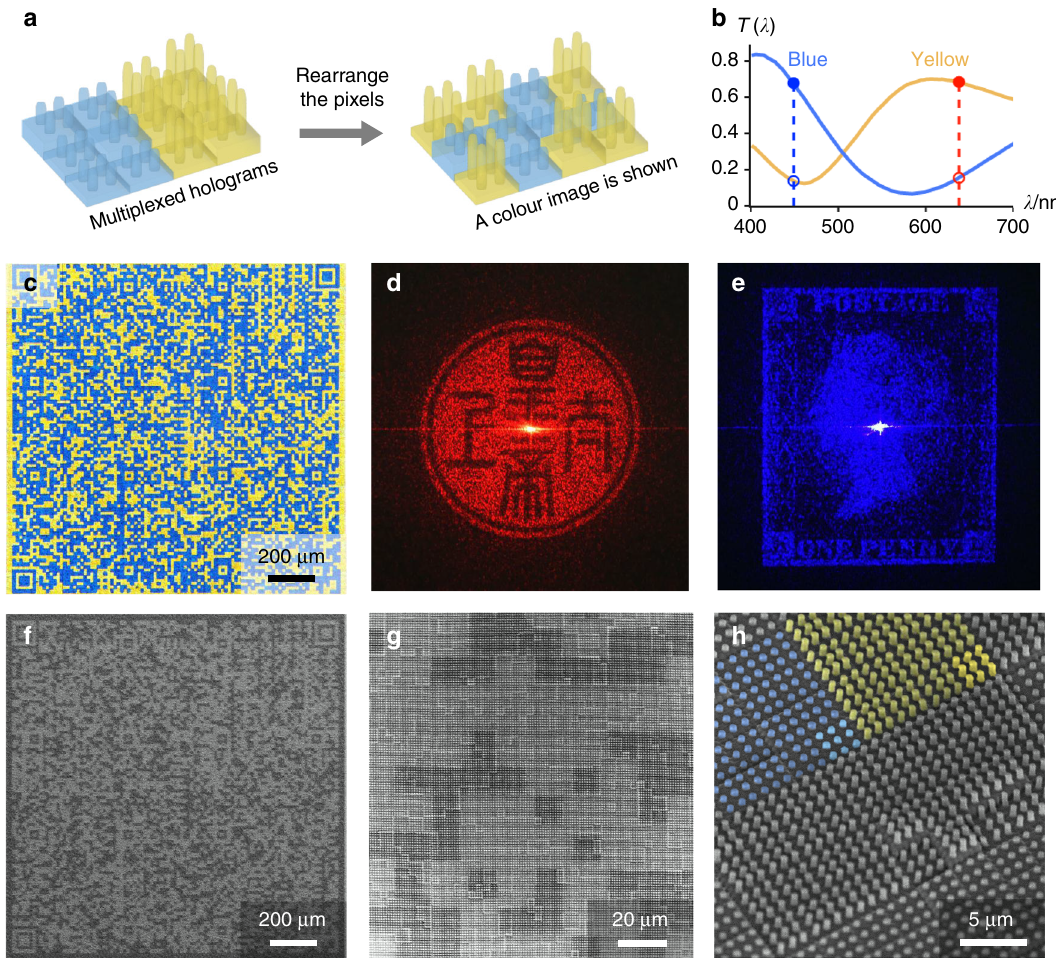
Fig. 3 Proof-of-principle of a two-tone holographic colour print. a Design principle of the holographic colour print: The ability to choose the amplitudes of the pixels independent of their phase makes it possible to rearrange the pixels in a multiplexed hologram (spatial freedom) so that the pixel arrangement contains meaningful information as well, allowing a colour image to be shown on top of the holograms. As long as the pixel arrangement is taken into account when calculating the phase, the individual holographic projections can still be maintained. b Transmission spectra of the yellow and blue colour fi lters used, which have mutually exclusive (orthogonal) transmission at the wavelengths of interest (638 nm red and 449 nm blue). Optical characterisation of the print: c Transmission optical micrograph of a two-tone multiplexed hologram in which the pixels are arranged to form a 480 × 480 pixel colour QR code (1.44 mm square). The blue colour fi lters (blue hologram channel) selectively pass blue light but not red light, whereas the yellow colour fi lters (red hologram channel) selectively pass red light but not blue light. Holographic projections in transmission, photographed on a white wall in a darkened room: d the image of a Chinese seal is shown under 638 nm red laser illumination and e the image of a Penny Black stamp is shown under 449 nm blue laser illumination. The projection size scales with the projection distance, reaching an average size of ~10 cm at a distance of 1 m. f – h Scanning electron micrographs (SEMs) of the print at various scales. Each holographic colour pixel consists of a 3 × 3 pillar array colour fi lter on top of a 3 × 3 μ m 2 phase plate, and each QR code pixel is a super-pixel comprising a 4 × 4 block of holographic colour pixels. In the close-up tilt-view SEM, a blue and a yellow QR code super-pixel are highlighted in false colour, and the bottom-right corner holographic colour pixel of each is further